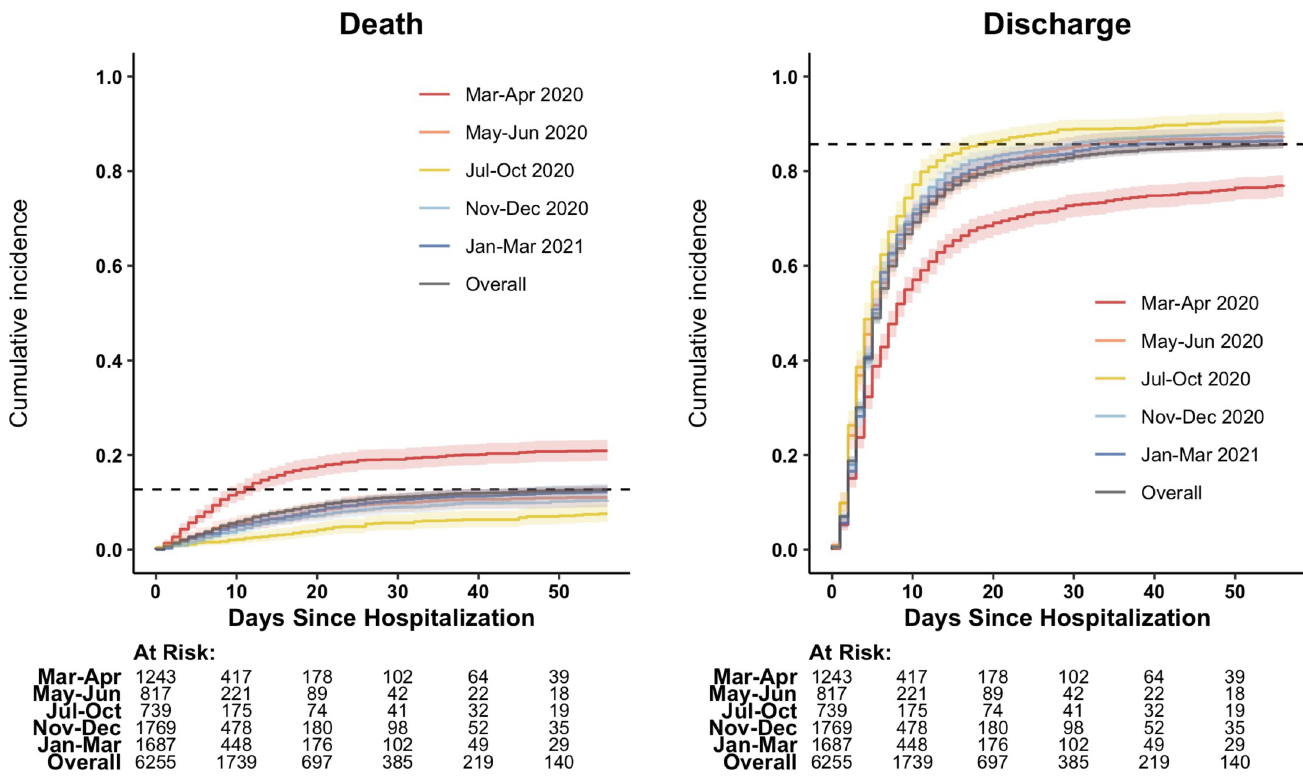
Fig 1. Cumulative incidence curves for death and discharge by month. N =